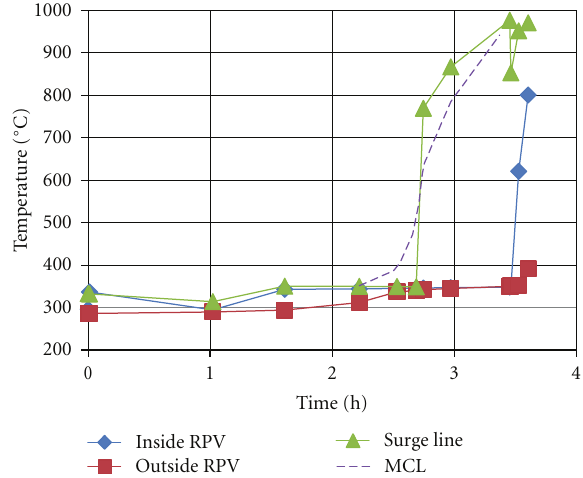
Figure 14: Temperatures versus transient time for di ff erent posi- tions.